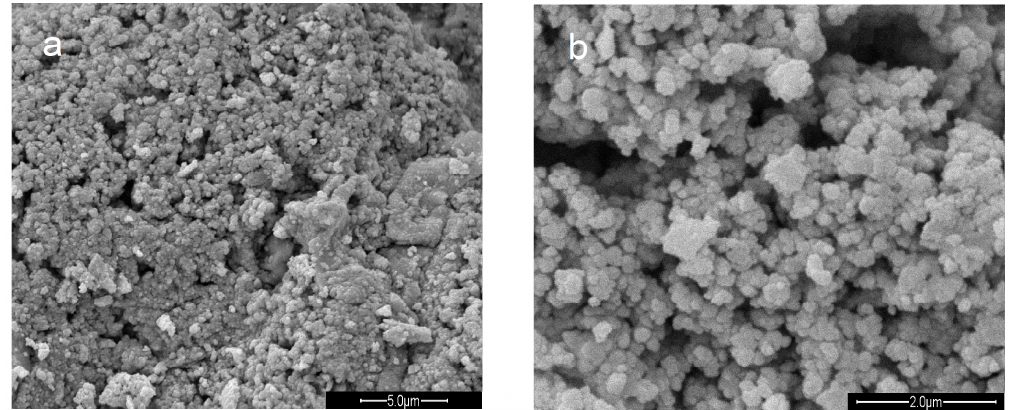
Figure 2. Scanning electron microscopy of the Pd/SO 42– /ZrO 2 catalyst (( a ) magnification 5k; ( b ) magnification 20k).